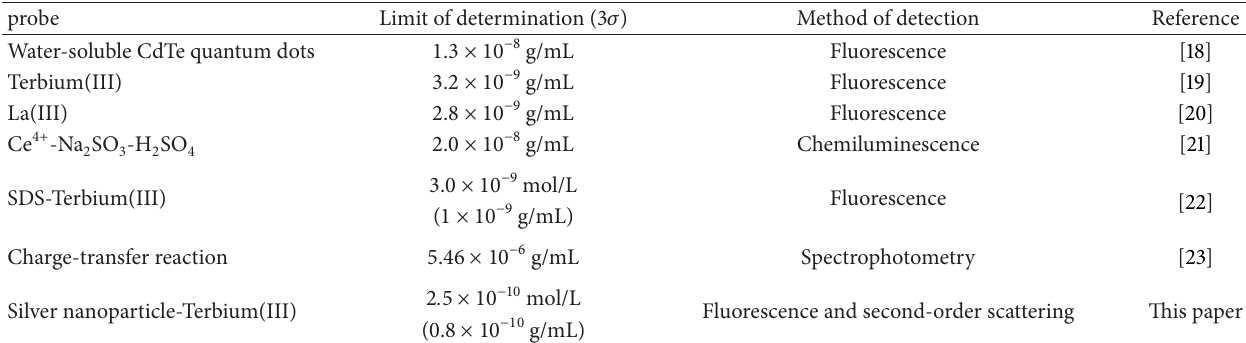
Table 5: Common methods for the determination of